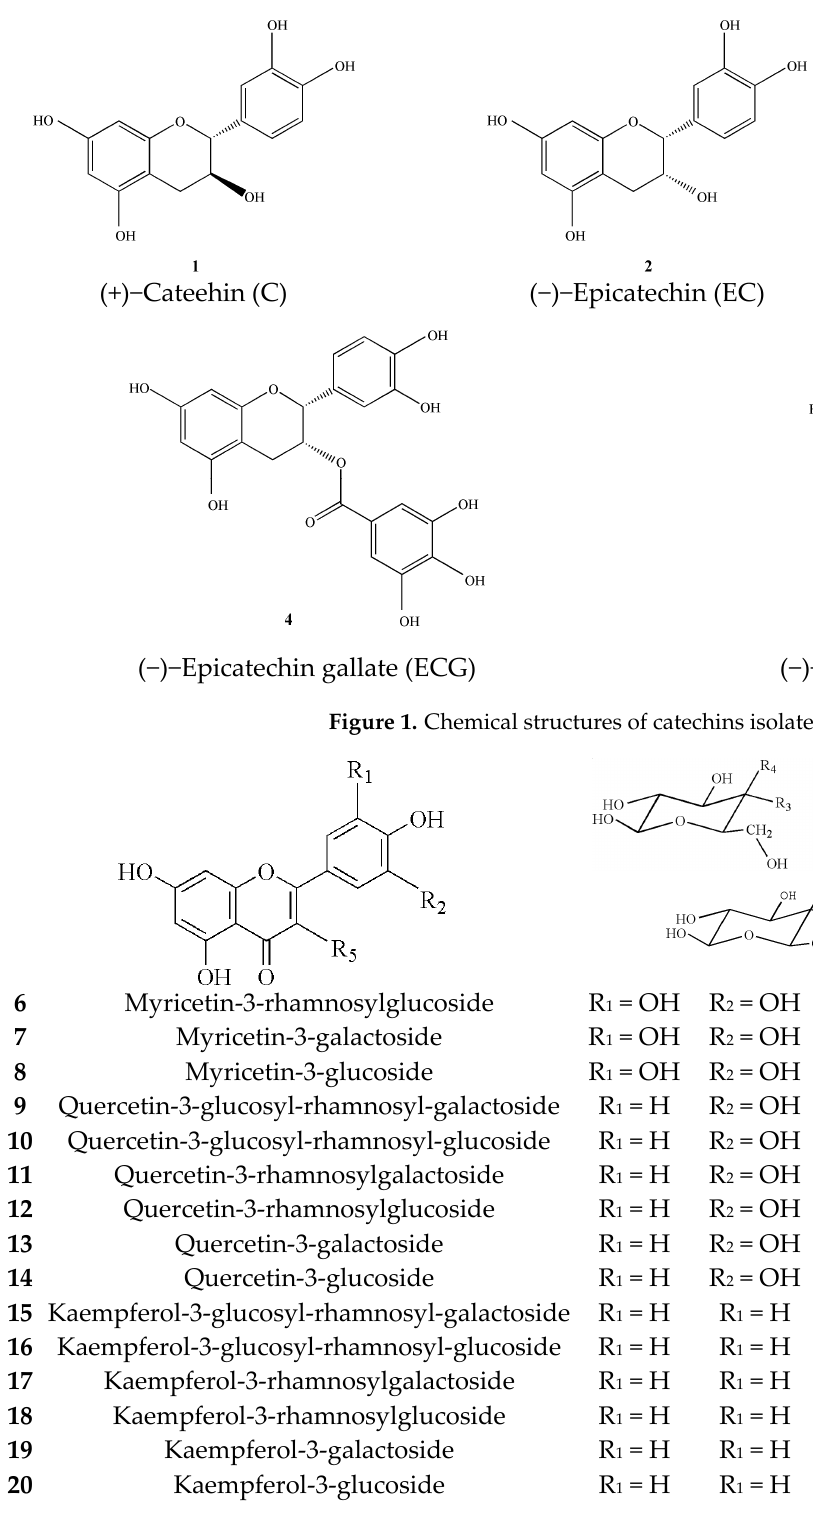
Figure 2. Chemical structures of flavonoids isolated from green